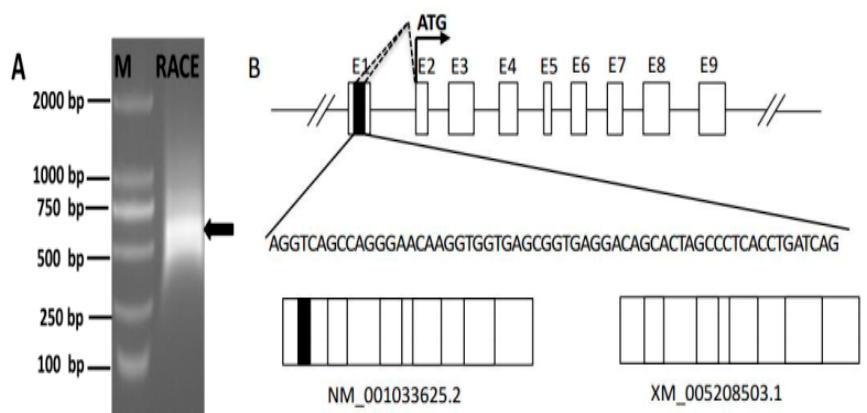
Figure 2. Identification of the SLC27A1 transcriptional start site. ( A ) Nested PCR was used to generate SLC27A1 5 ′ RACE products that were subjected to agarose gel electrophoretic separation, with arrows corresponding to the amplicons. ( B ) The initiation sites for the two SLC27A1 mRNA variants identified via 5 ′ RACE are shown along with a partial genomic structure for this gene, and the initiation codon ATG are indicated with arrows. White boxes identify constitutive exons, while the black box highlights the alternatively spliced region. Introns are indicated by solid lines and dashed lines indicating potential splicing variations.